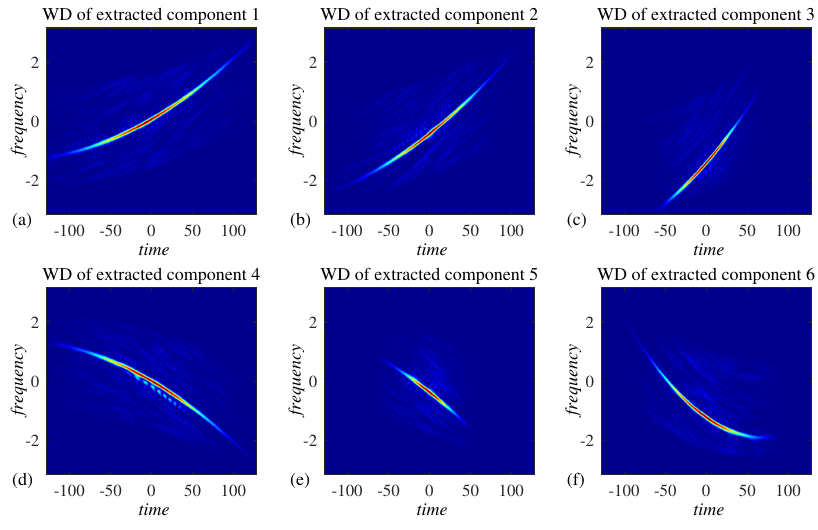
Figure 3. Time-frequency representations of eigenvectors corresponding to the largest six eigenvalues of the autocorrelation matrix R of the signal from Example 1. Each eigenvector represents a linear combination of non-stationary components with polynomial frequency modulation. Panels ( a – f ) show Wigner distribution of each eigenvector.